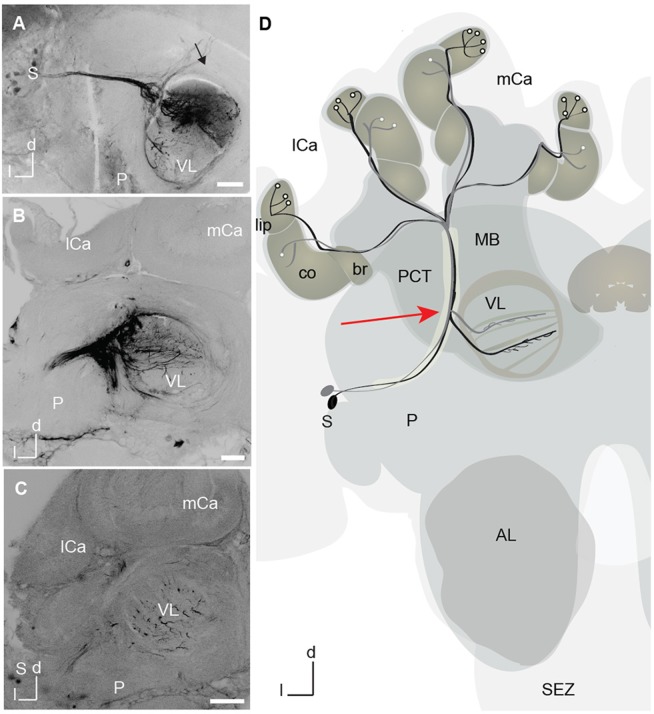
A3 mushroom body extrinsic neurons marked with dye at the tip of the recording electrode. (A) Projection view of a mass-fill of A3 dorsal neurons after electrode injection with Microruby on the tip of the electrode. Tracts of the dorsal somata cluster and the horizontal layers in the vertical lobe (VL) are visible. Axons project toward the calyx in the protocerebral calycal tract (PCT, black arrow) revealing A3 neurons. (B) Projection view of a different mass-fill of A3 neurons after electrode injection with Microruby on the tip of the electrode. Again, tracts of A3 dorsal (d) neurons are visible together with a horizontal layer in the VL. (C) Projection view of a mass fill of A3d neurons with arborizations in the VL. (D) Schematic drawing of two different innervation types of A3 feedback neurons. In black A3 neuron connecting lip and corresponding layer in the VL, in gray A3 connecting collar and corresponding layer in the VL. A3 neurons were also found to connect the basal ring and the corresponding basal ring layer in the VL. All types connect to the medial lobe. Another class-A3 lobe connecting neurons—do not innervate the calyx (not shown) (Zwaka et al., 2018). The red arrow points to the recording site. AL, antennal lobes; br, basal ring; CB, central body; co, collar; d, dorsal; P, protocerebrum; l, lateral; lCa, lateral calyx; MB, mushroom bodies; mCa, medial calyx; PCT, proto cerebral calycal tract; SEZ, subesophageal zone; S, Soma; VL, vertical lobe.